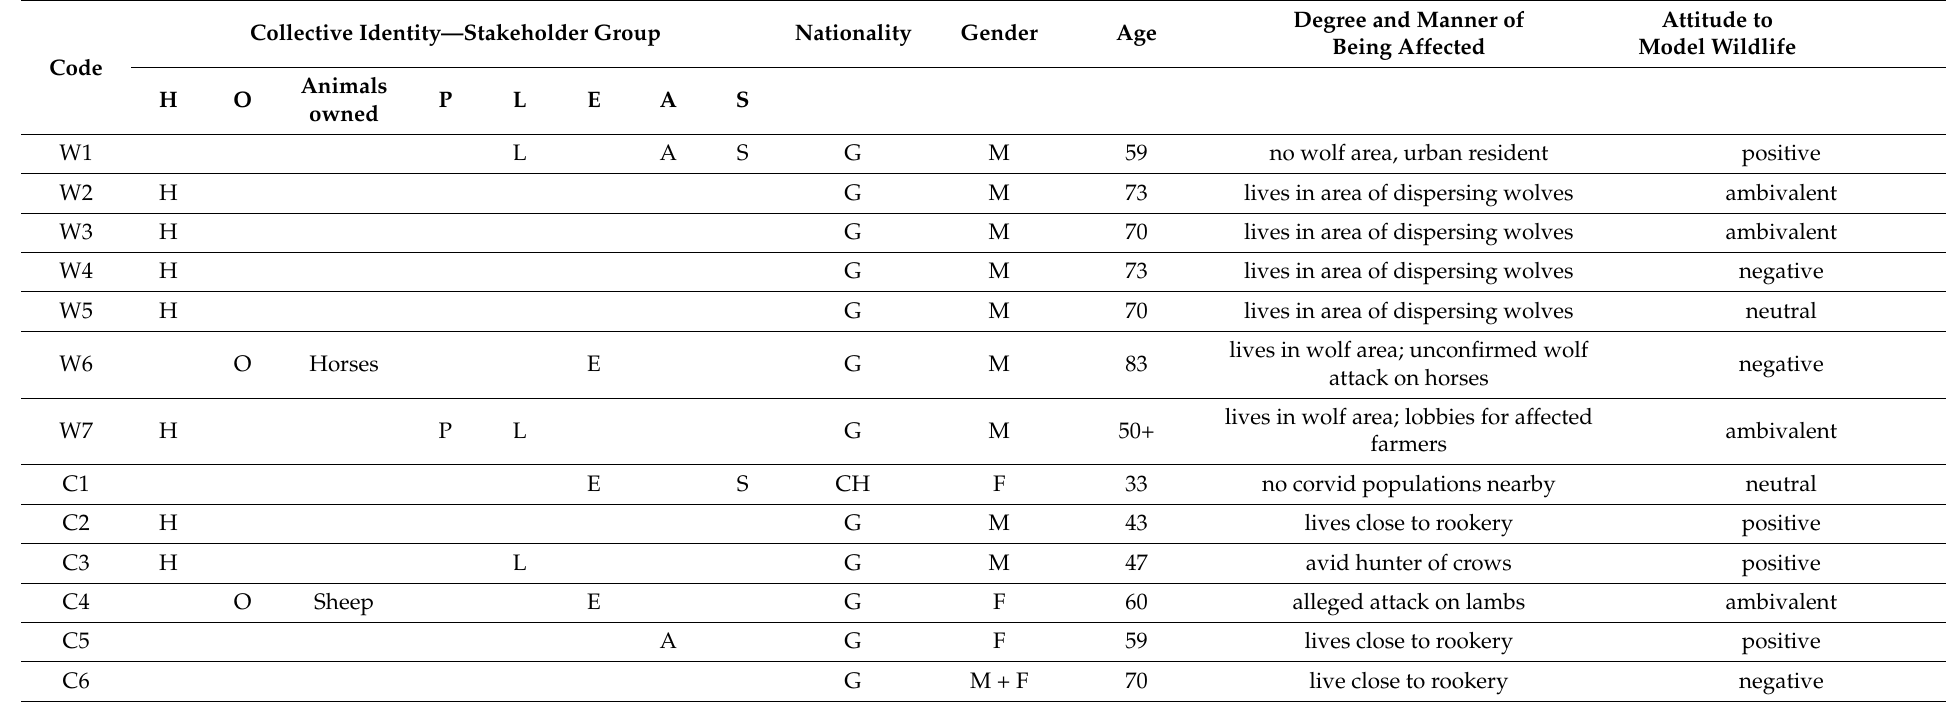
Table A2. Sociodemographic information on interview